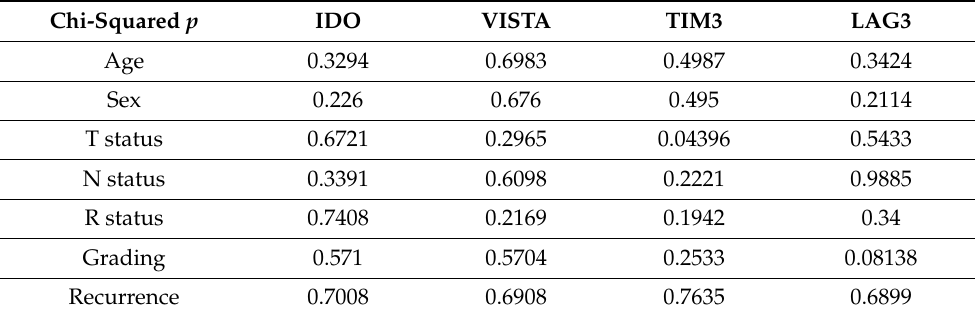
Table 4. Correlation of clinicopathological parameters with the expression of the immune checkpoint molecules IDO, VISTA, TIM3, and LAG3. The chi-square test for independence was used to analyze the correlation table formed by two categorical variables at a